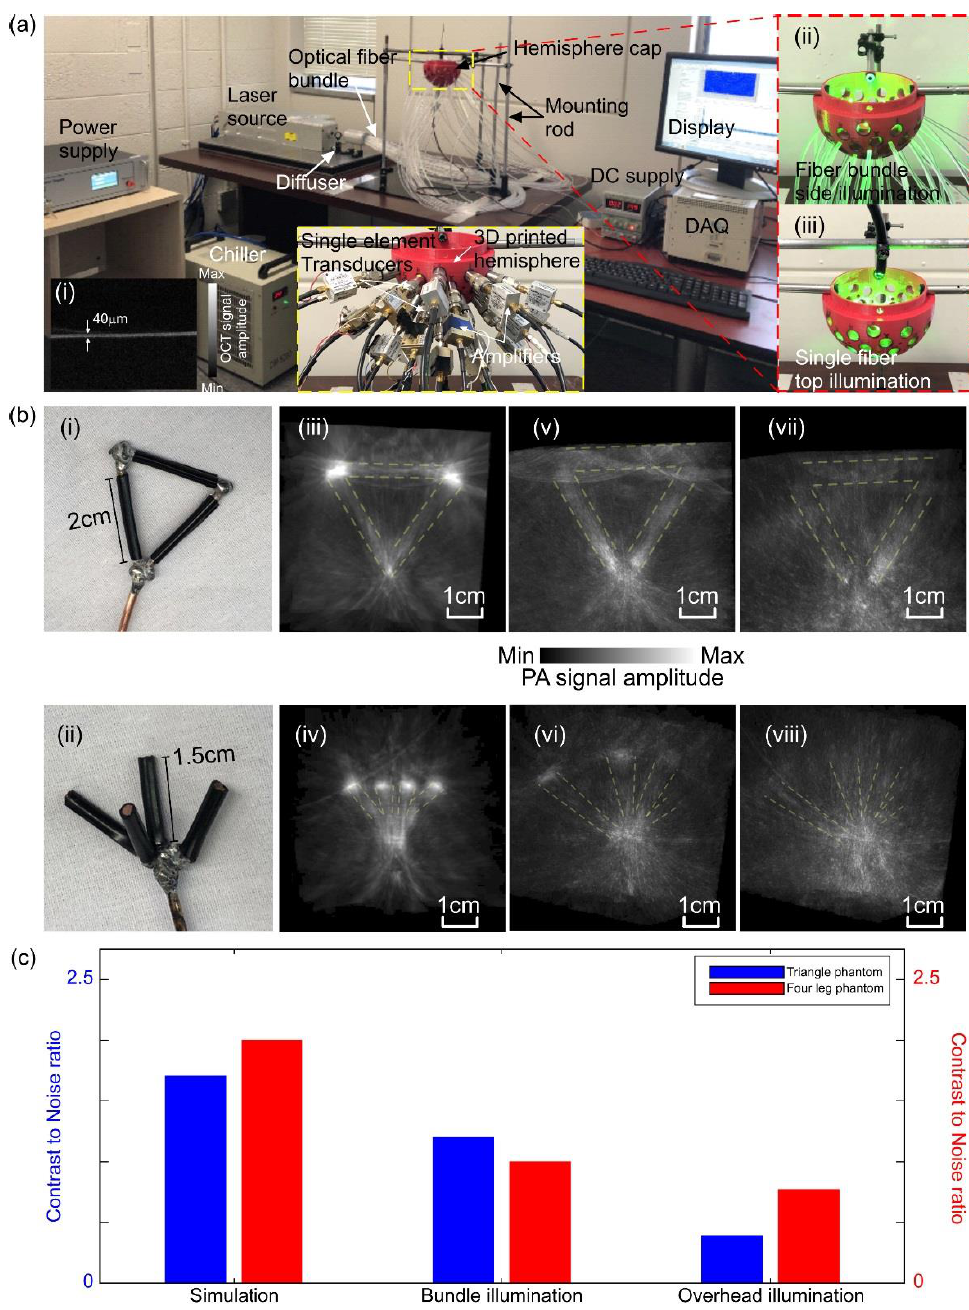
Figure 2. ( a ) Experimental setup, (i) measurement of saran wrap thickness using OCT imaging system, (ii) full-field illumination, and (iii) overhead illumination; ( b ) two imaging targets used in experimental configuration: photograph of (i) triangle phantom, (ii) four-leg phantom, (iii,iv) simulation results of triangle and four-leg phantoms, (v,vi) full-field illumination reconstruction results, and (vii,viii) overhead illumination reconstruction results; and ( c ) relative values of contrast to noise ratio of the reconstructed images of the triangle (blue) and four-leg (red) phantoms. Finally, based on the transducer diameter and central frequency, the target object in the hemisphere is within the near-field. Imaging within the near-field results in rapid oscillation in